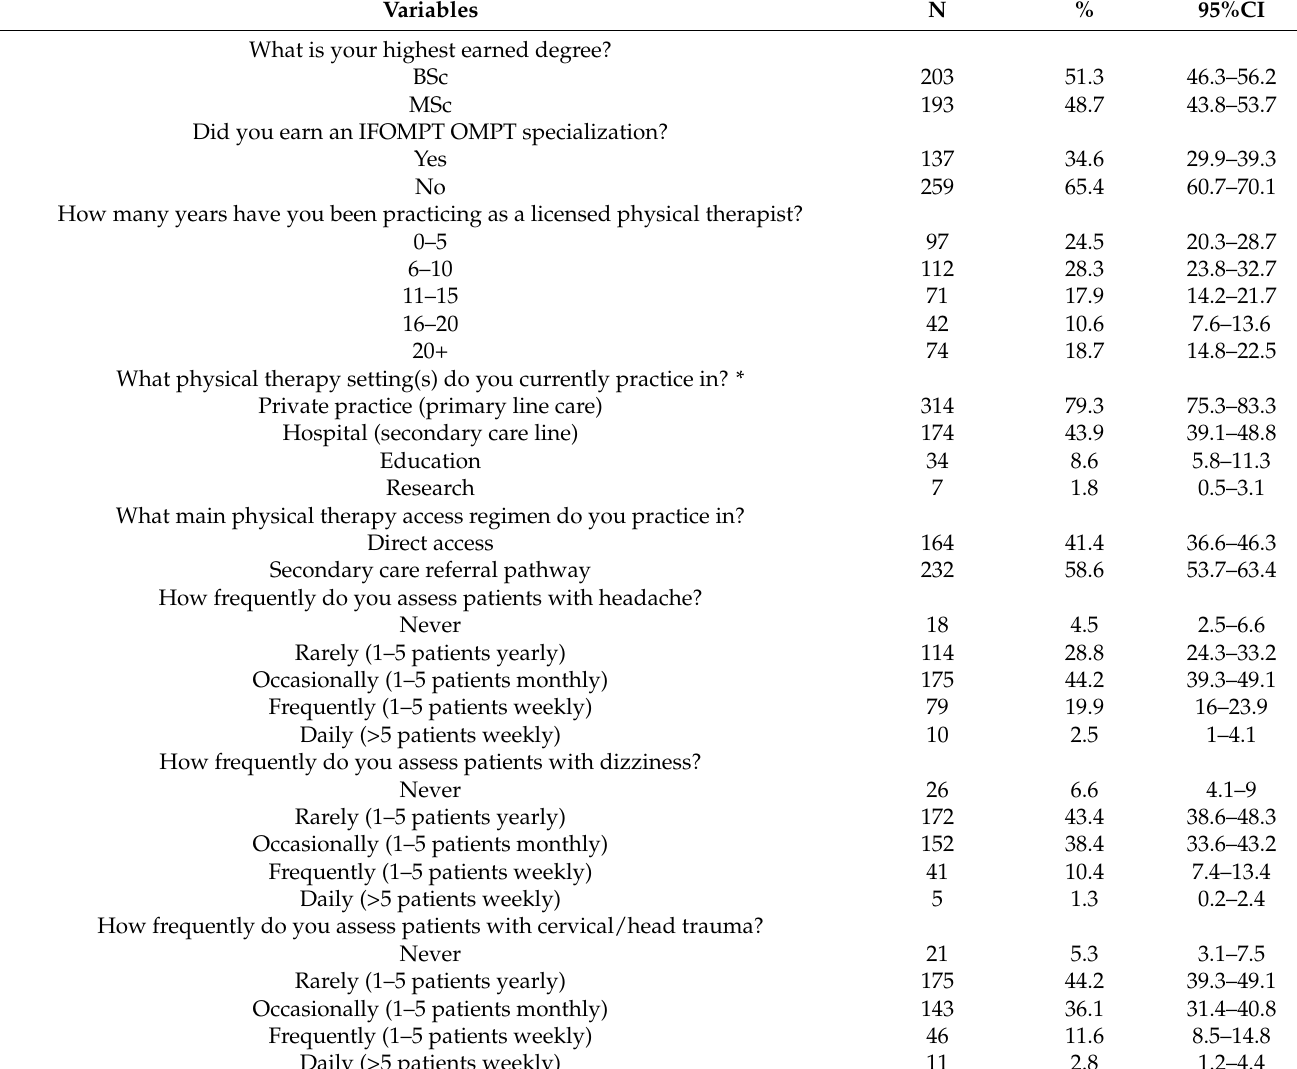
Table 1. Demographic and clinical characteristics of the